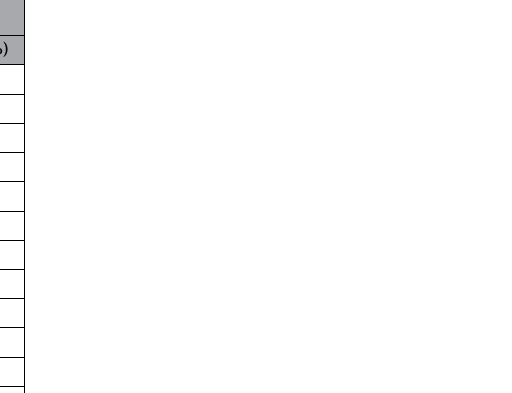
Calculated porosity (Our) Open (%) Micro (%)